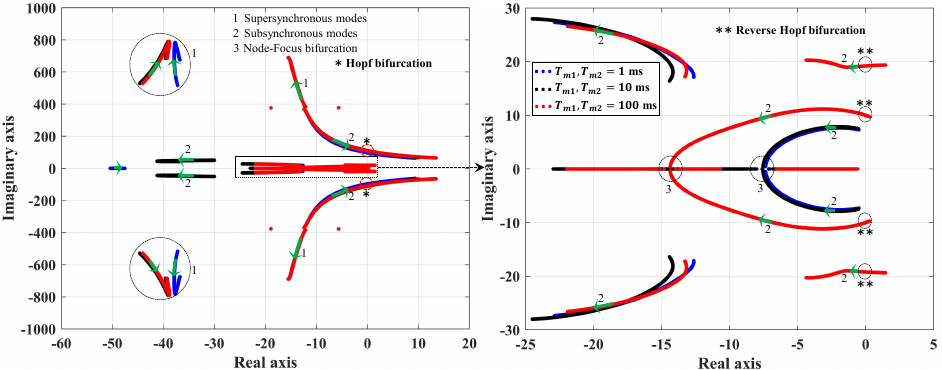
Figure 10. Eigenvalues with SVC for different measurement time